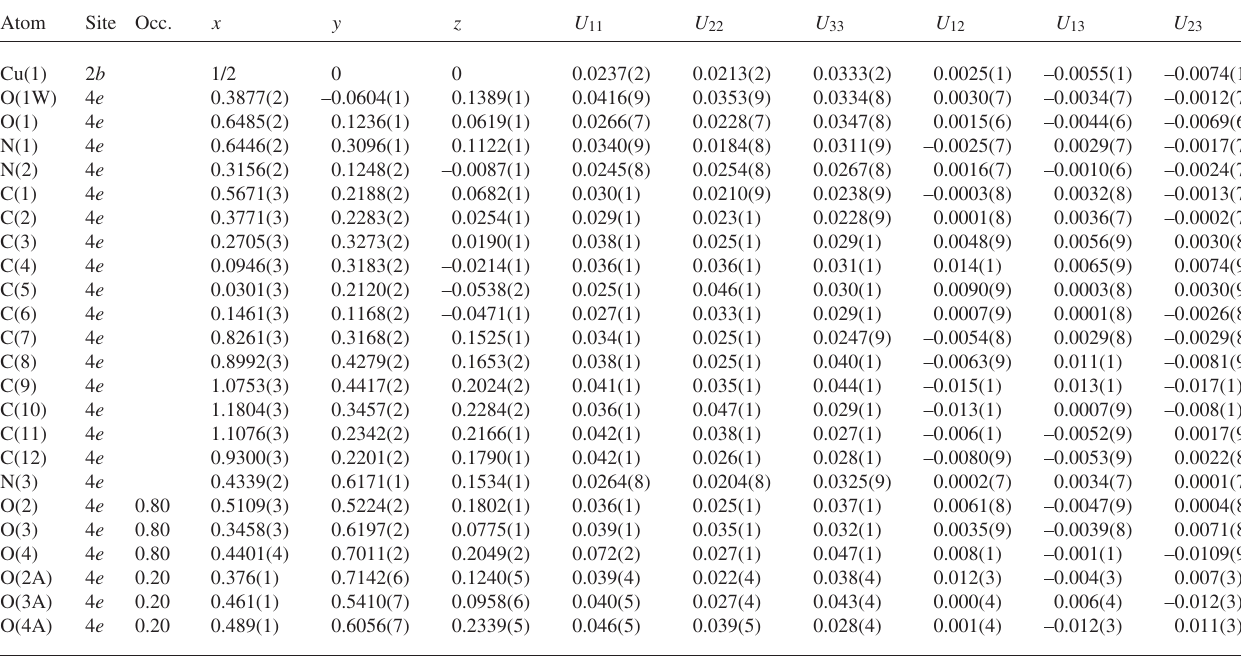
Table 3. Atomic coordinates and displacement parameters (in Å 2 ) .